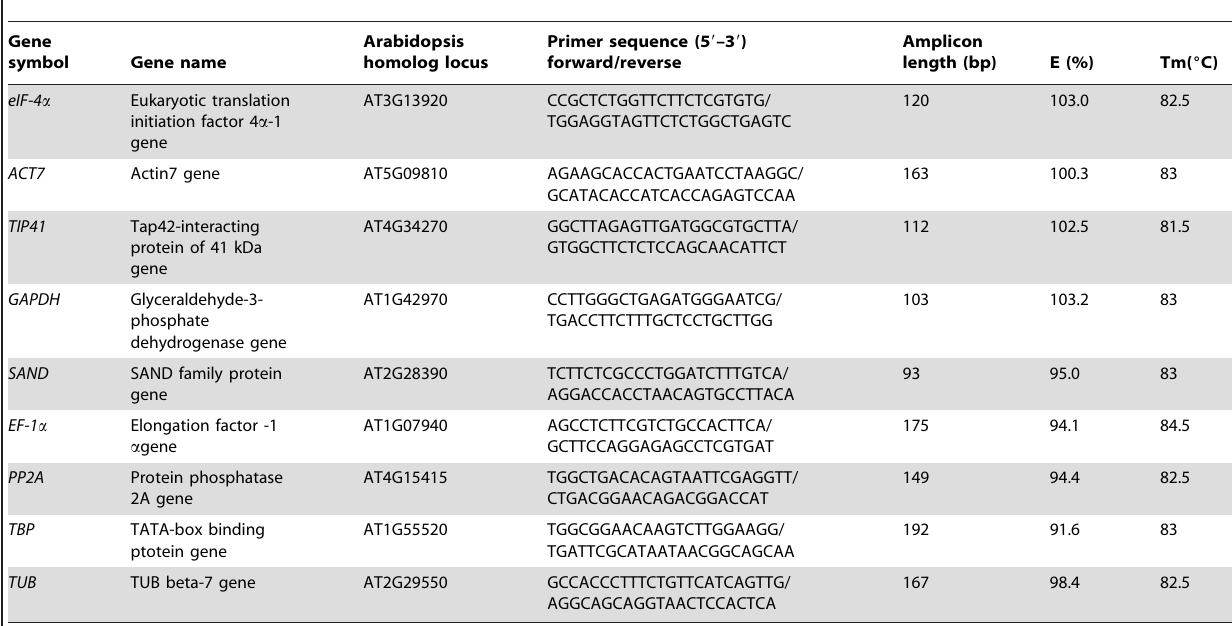
Table 1. Descriptions of candidate reference genes in O.